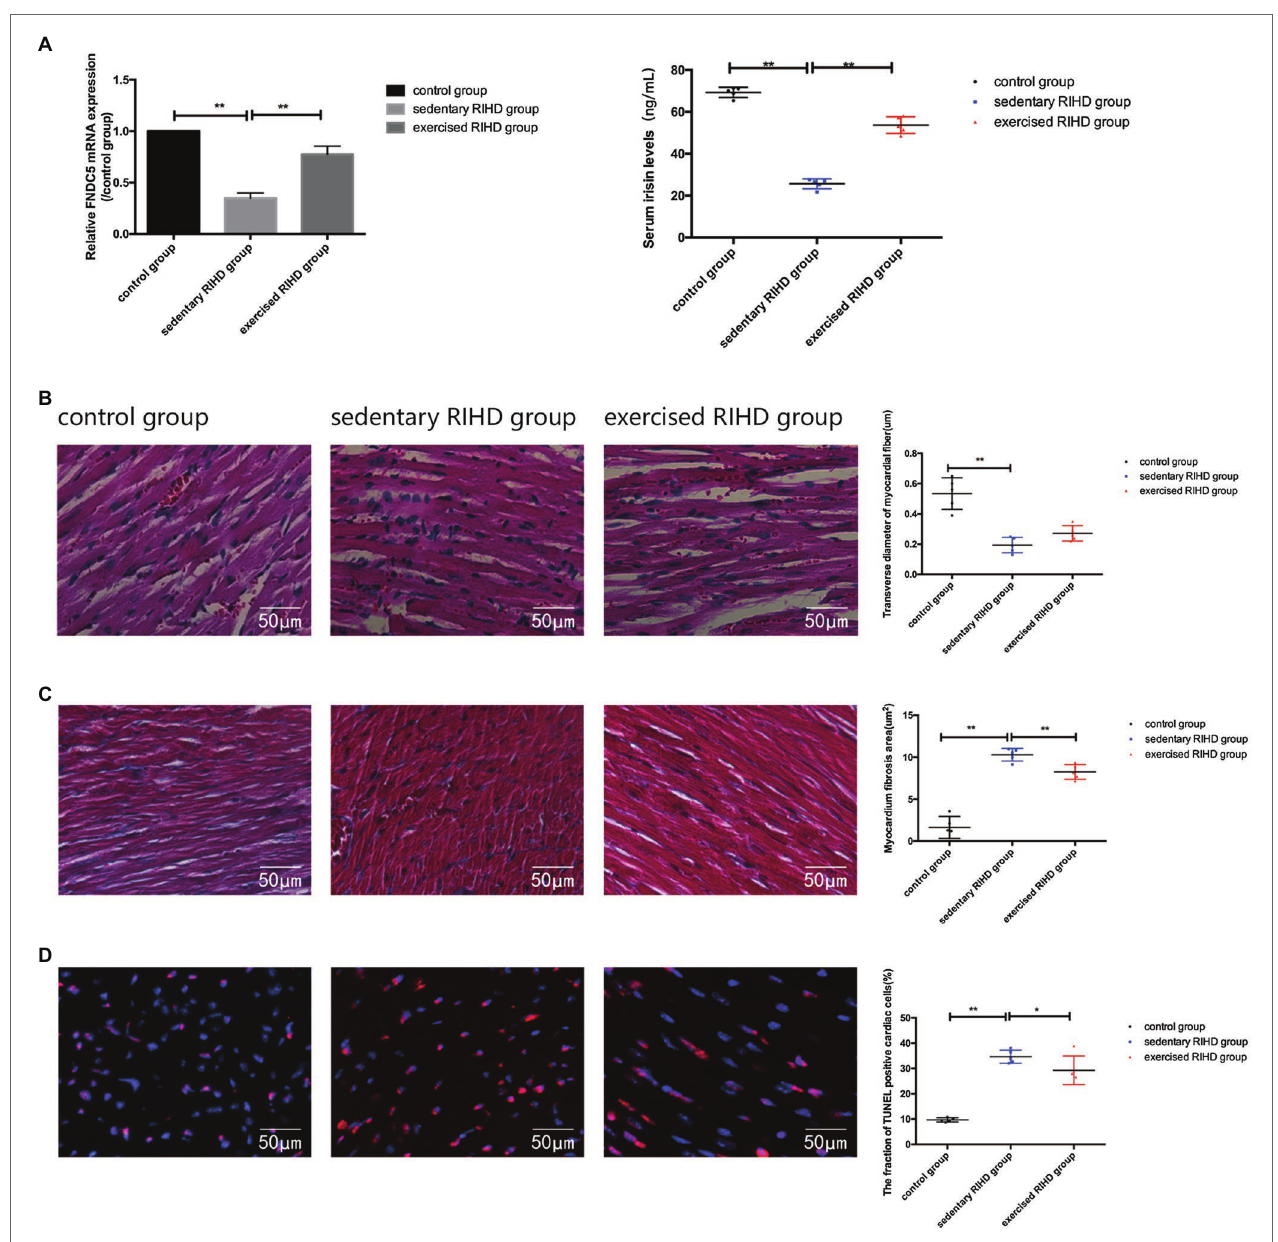
FIGURE 3 | Effect of exercise on FNDC5/irisin expression and cardiac myopathy in RIHD mice. (A) Comparison of the relative mRNA expression levels of FNDC5/ irisin among the three groups. (B) Hematoxylin–eosin staining of the three groups ( n = 3 samples/group). Magnification, ×400. The transverse diameters of the myocardial fibers between groups were compared by ANOVA. (C) Masson staining of the three groups ( n = 3 samples/group). Magnification, ×400. The quantified myocardial fibrosis areas among the groups were compared by ANOVA. (D) TUNEL-positive cells (indicated by the colocalization of red and blue fluorescence) were counted in three groups ( n = 3 samples/group). Magnification ×400. The fractions of TUNEL-positive cells were compared by ANOVA. * p < 0.05, ** p <